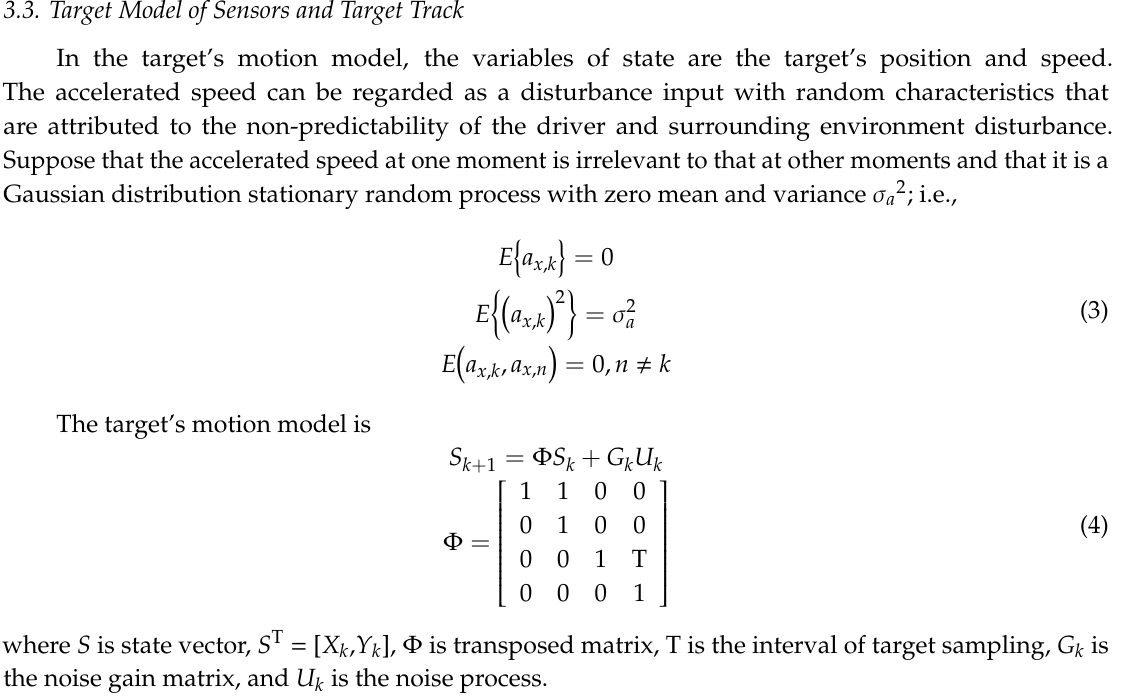
Figure 3. Division of Air Traffic Management (ATM) zone.